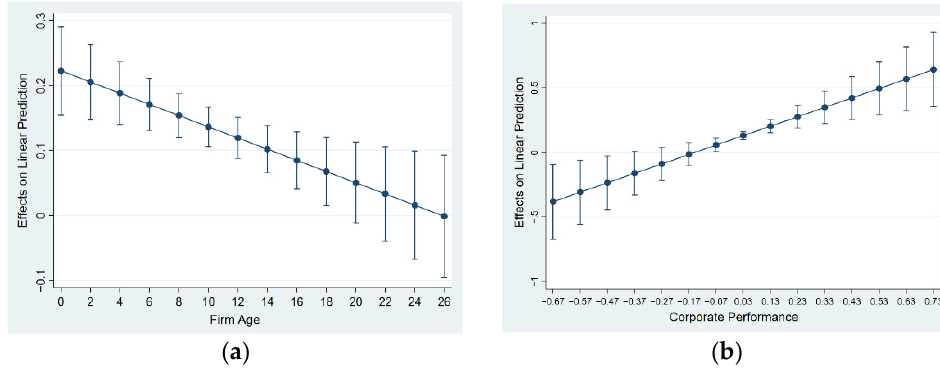
Figure 2. The average marginal effect of enterprise individual characteristic variables.